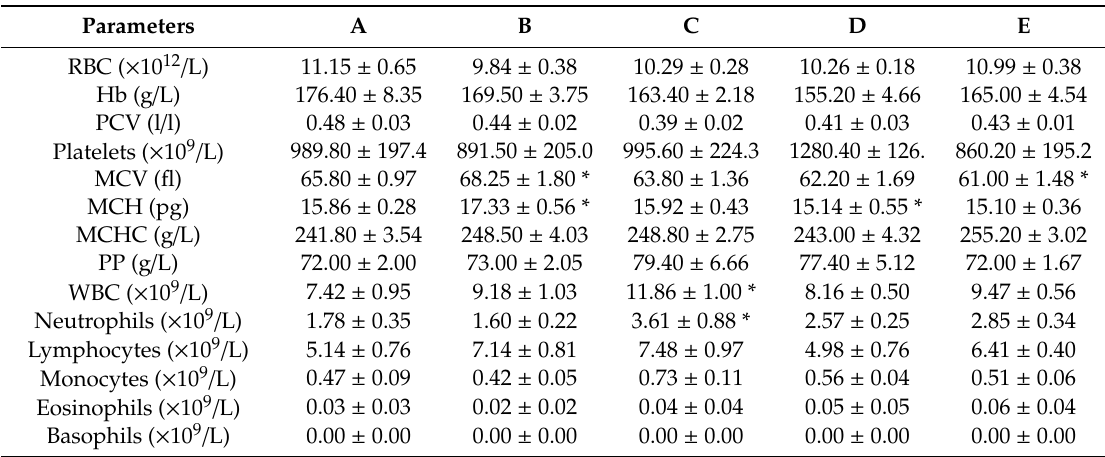
Table 8. Haematological parameters (mean ± SEM) of female ICR mice in subacute toxicity study of